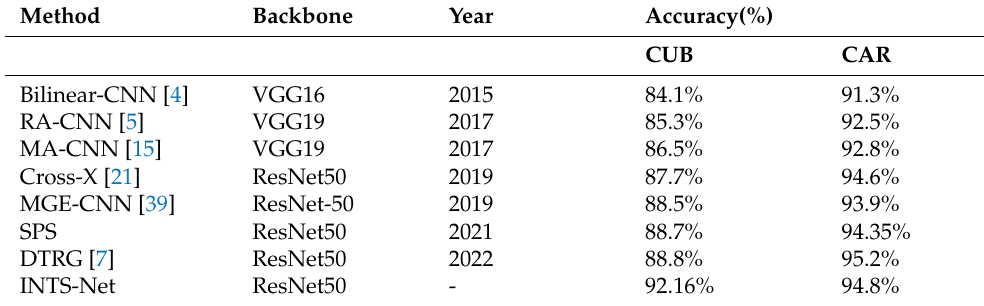
Table 4. Comparison with state-of-the-art methods on classification accuracy with the CUB, the CAR. Method